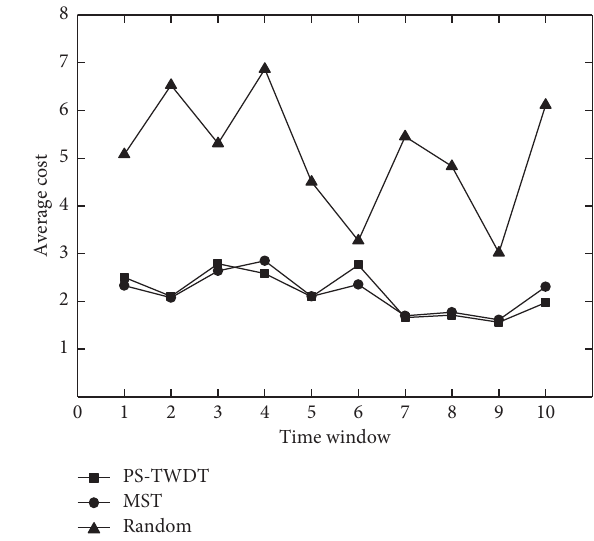
Figure 11: Average data